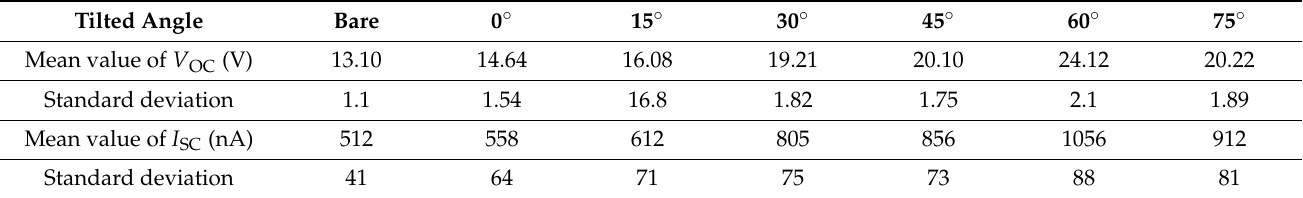
Table 2. Each mean value of electrical output generated from the TSR and its standard deviation according to the tilted